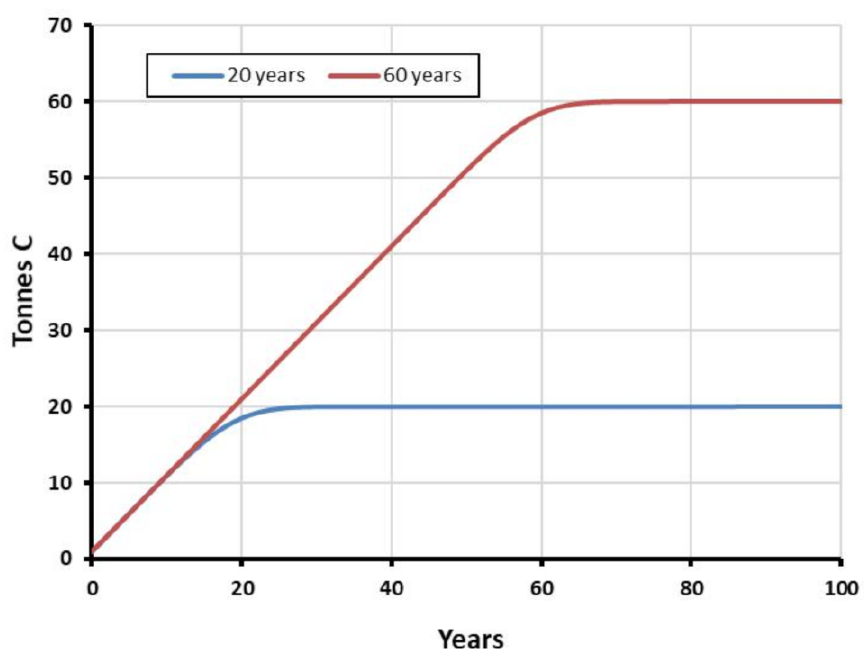
Figure 3. Effect on total carbon stored and time to equilibrium for a carbon pool with an input of 1 tonne C per year and a carbon loss represented by a normal distribution of